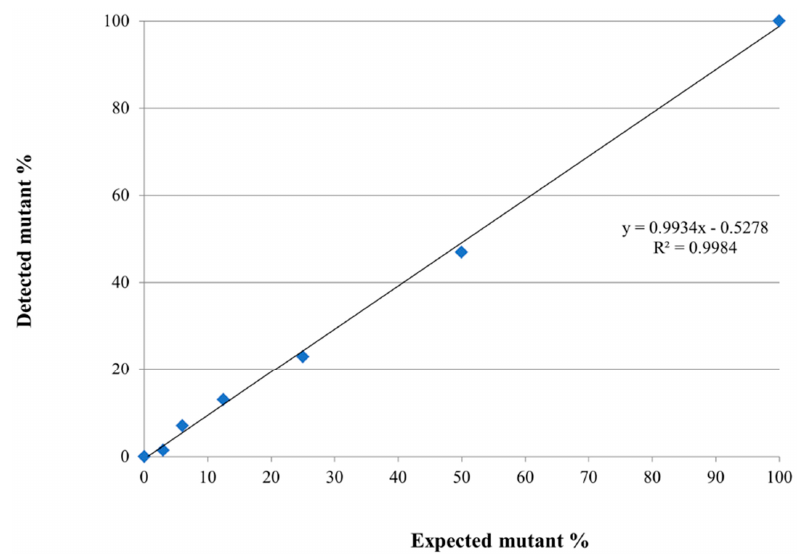
Figure 2. Validation of the detection accuracies of pyrosequencing. The scatter plot indicates the average of the observed somatic mutation rates of the standard materials with mutation rates of 100%, 50%, 25%, 12.5%, 6%, 3%, and 0%. Regression analysis was performed to determine the correlation between the observed somatic mutation rates and the expected somatic mutation rates.